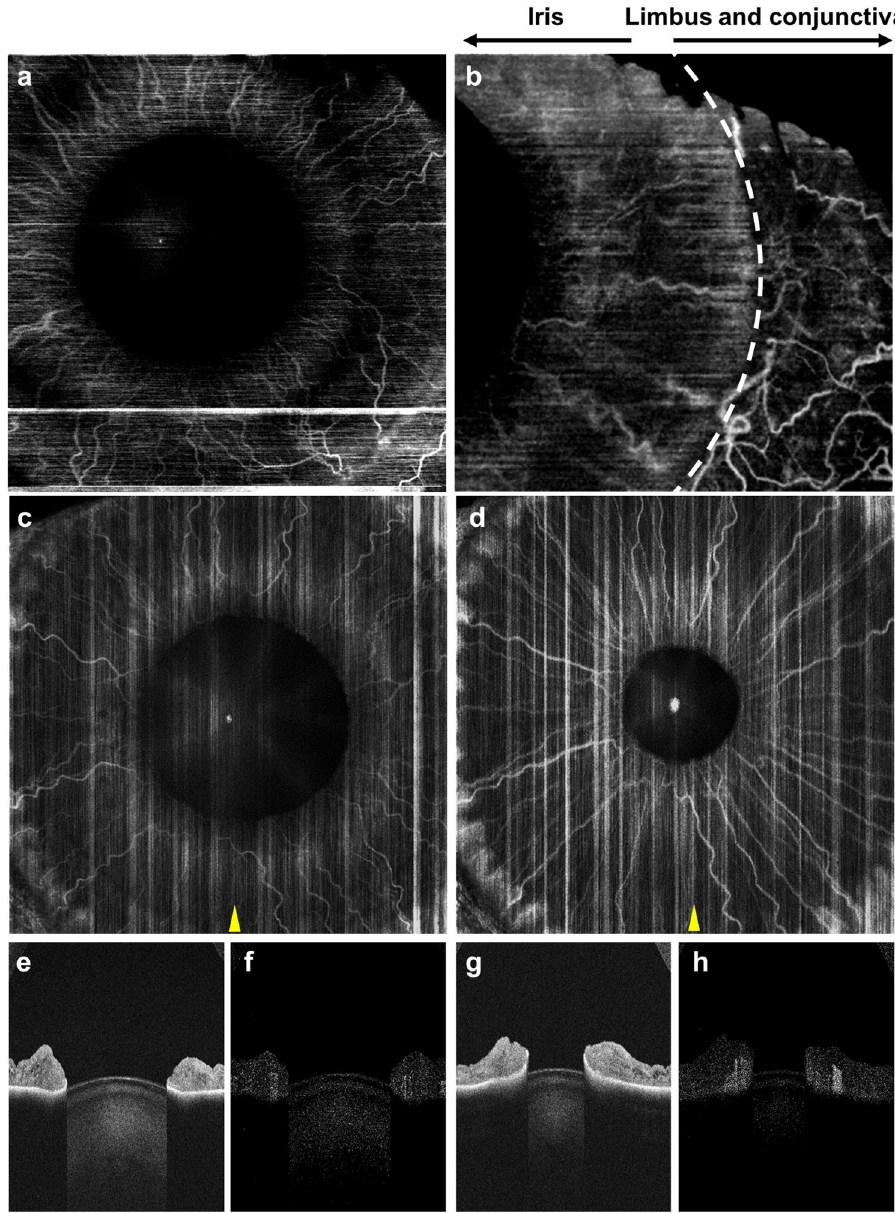
Figure 8. Iris OCTA using the SS-OCT prototype instrument. ( a ) 9-mm and ( b ) 6-mm OCTA of an Asian eye (dark pigmented). ( c )–( d ) 12-mm OCTA of a Caucasian eye (lightly pigmented). ( c ) shows a dilated pupil in dark environment, where ( d ) shows a constricted pupil in response to white light stimulation. Iris vessels show morphological changes following pupillary constriction, where the vessels appear straighter and brighter. ( e , g ) Structural and ( f , h ) angiographic B-scans extracted from the corresponding scans at the locations indicated by the yellow